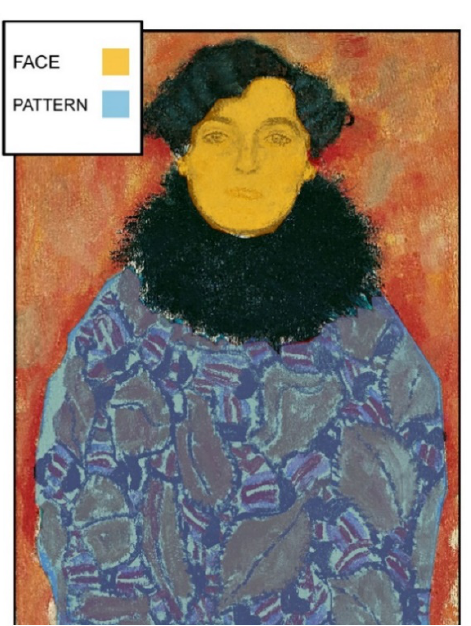
Figure 3: AOIs traced on Gustav Klimt, Johanna Staude